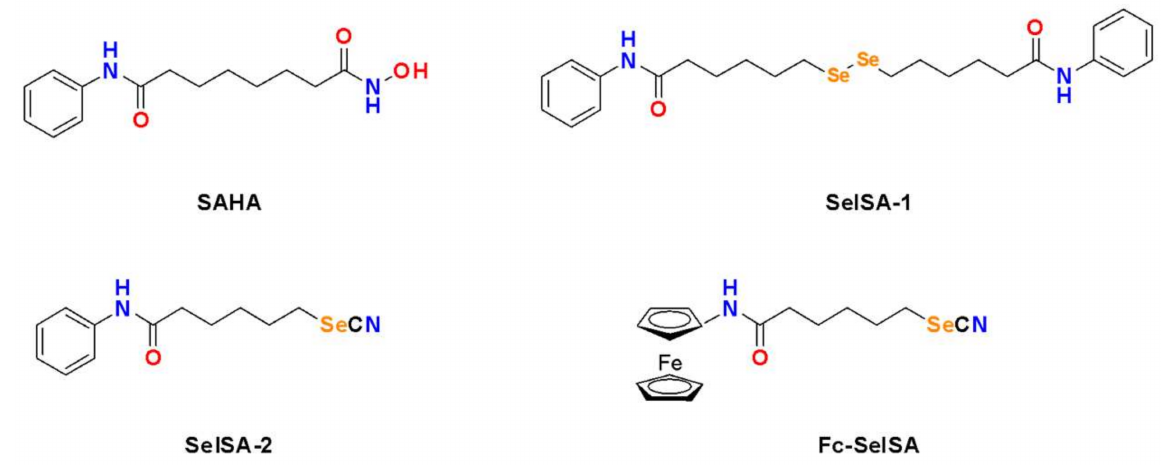
Figure 5. Structures of the HDAC inhibitor SAHA and its selenium-containing